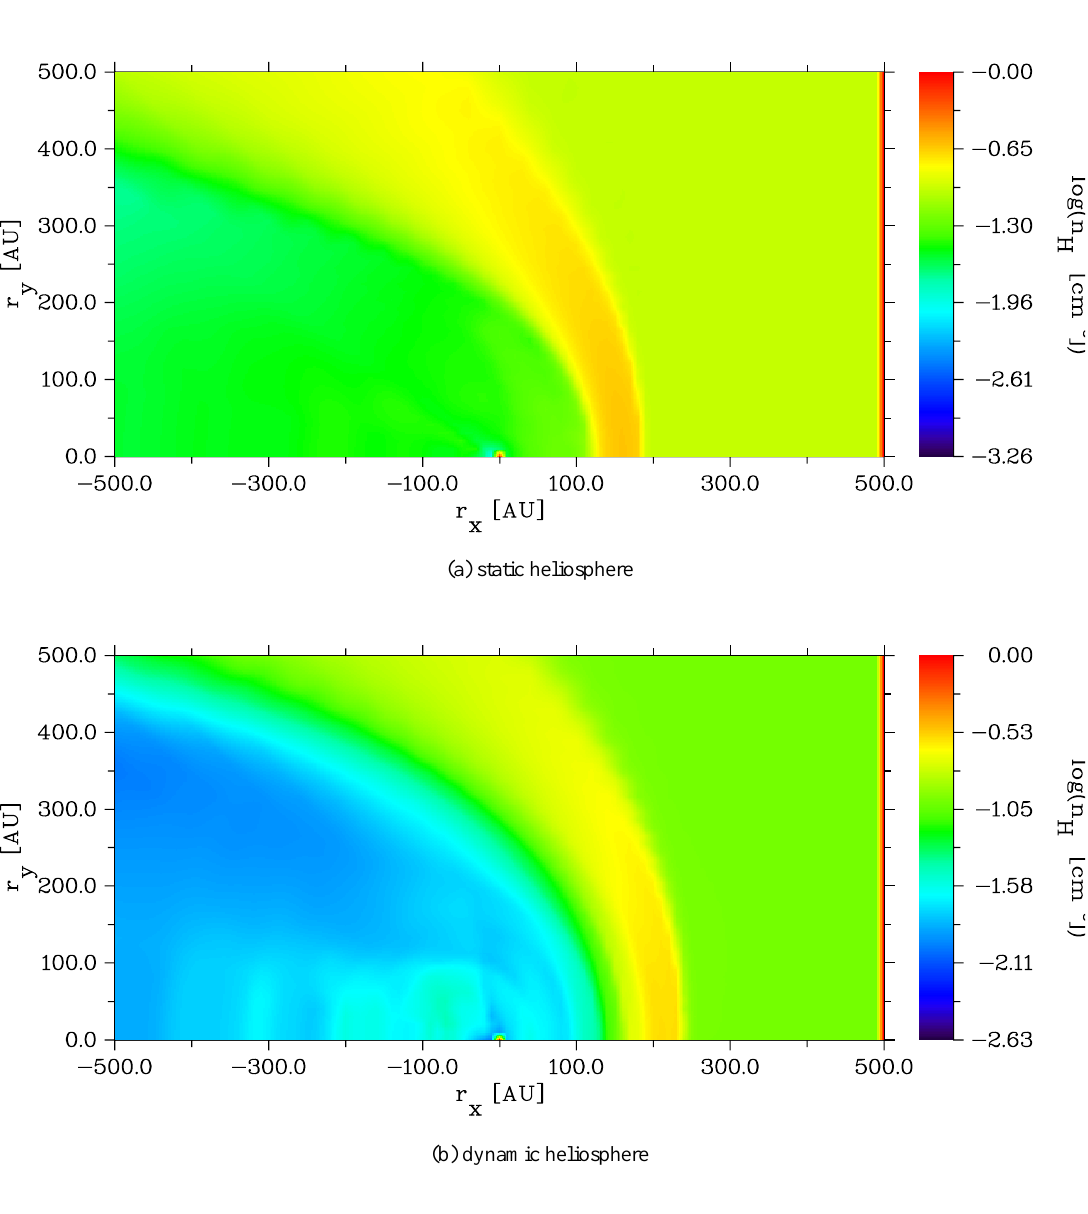
case of a large Global Merging Interaction Region